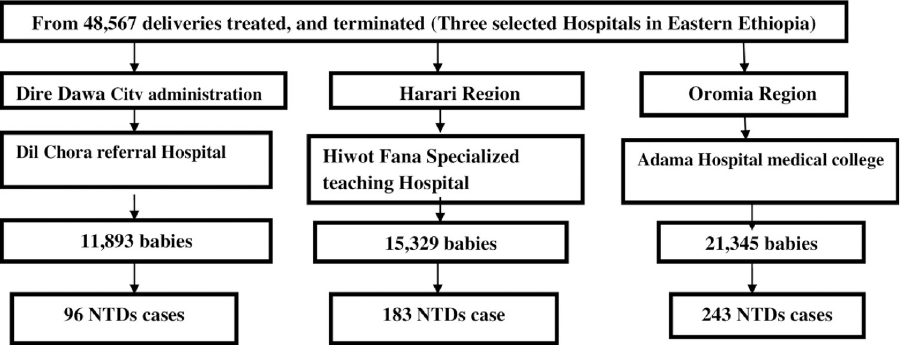
Fig 1. Schematic presentation of sampling procedure in Eastern